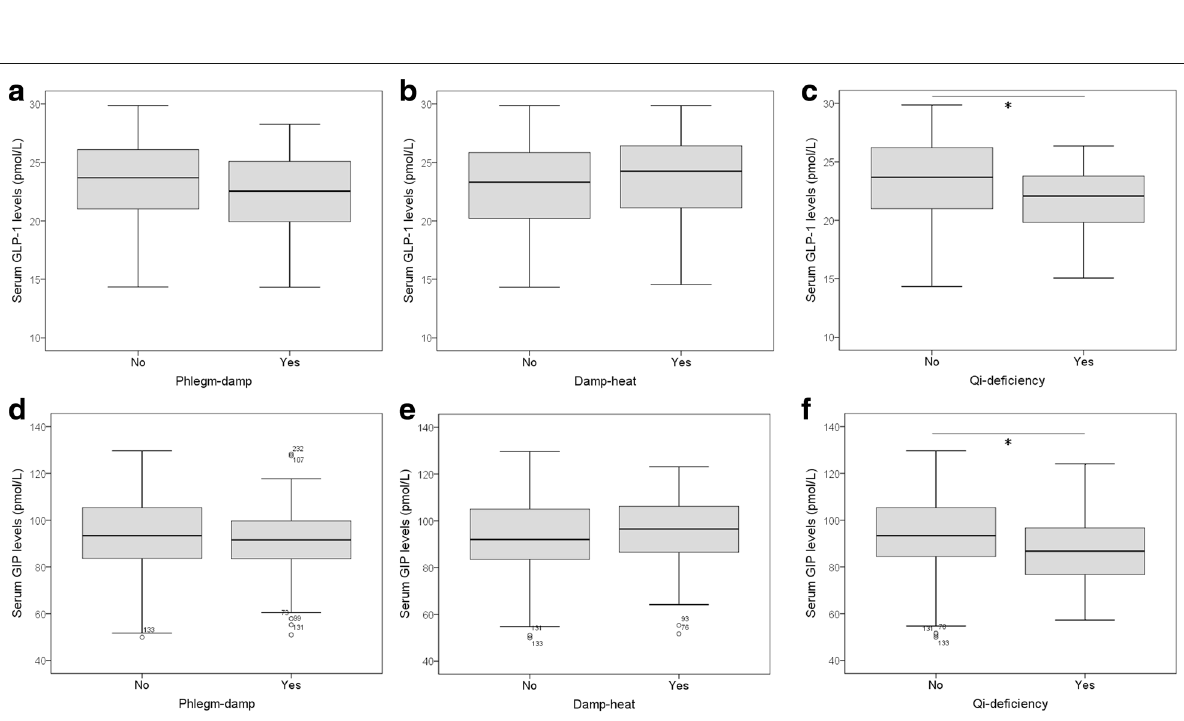
Fig. 4 Serum levels of gut hormones in IGR subjects with TCM body constitutions. The associations of GLP-1 and GIP with Phlegm-damp ( a, d ), Damp-heat ( b, e ) and Qi-deficiency ( c, f ) were investigated. Serum GLP-1 and GIP levels are significantly lower in IGR subjects with Qi-deficiency as compared with IGR subjects without Qi-deficiency. Wilcoxon-Mann-Whitney test was performed. *P<0.05. IGR: impaired glucose regulation; GLP-1: glucagon-like peptide-1; GIP: gastric inhibitory